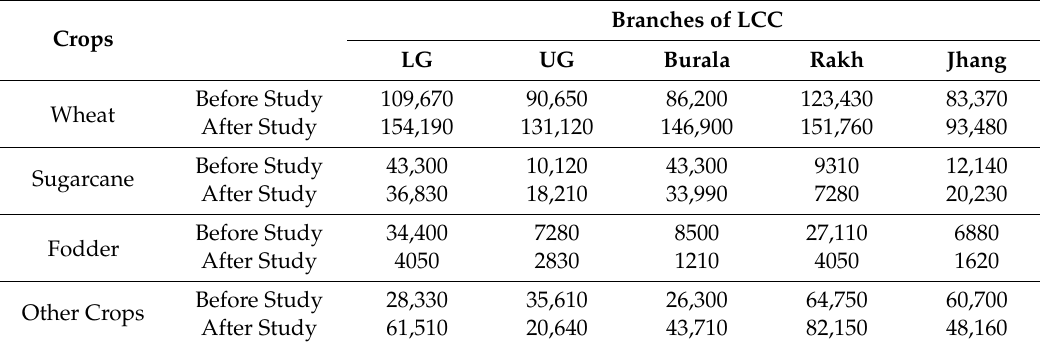
Table 10. Acreage (hectare) of Rabi crops on branches of the LCC.